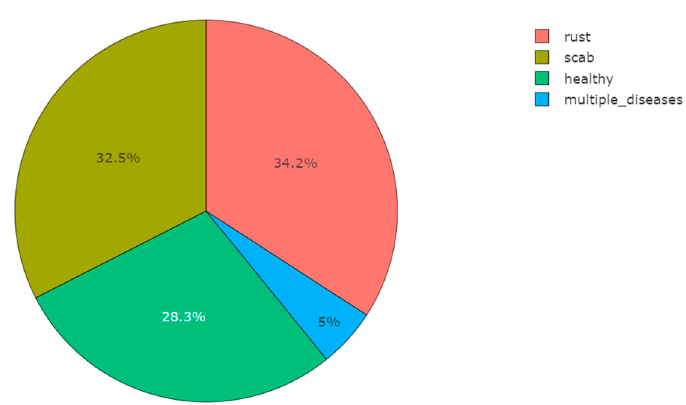
Figure 5. Distribution of classes in our dataset.